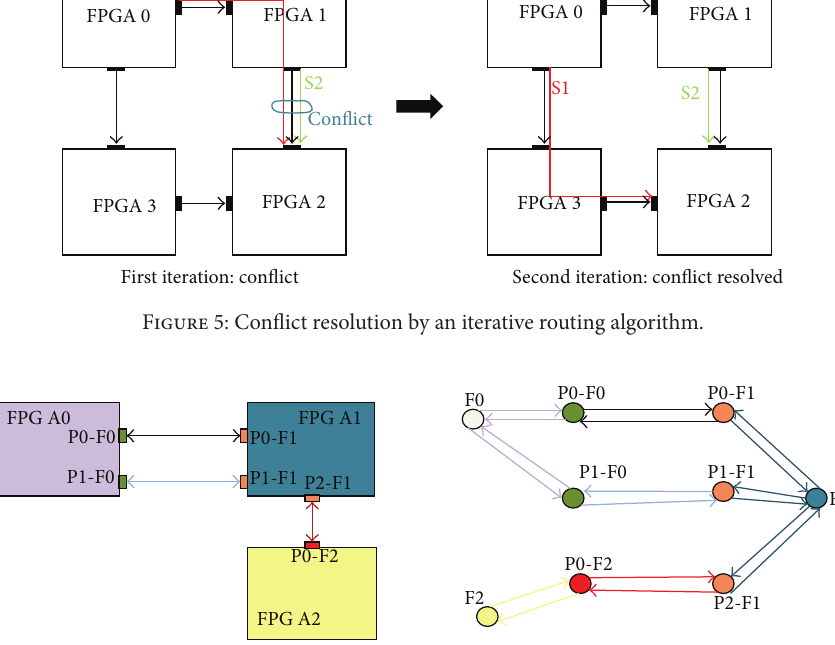
Figure 6: Modelling multi-FPGA platform as routing graph.